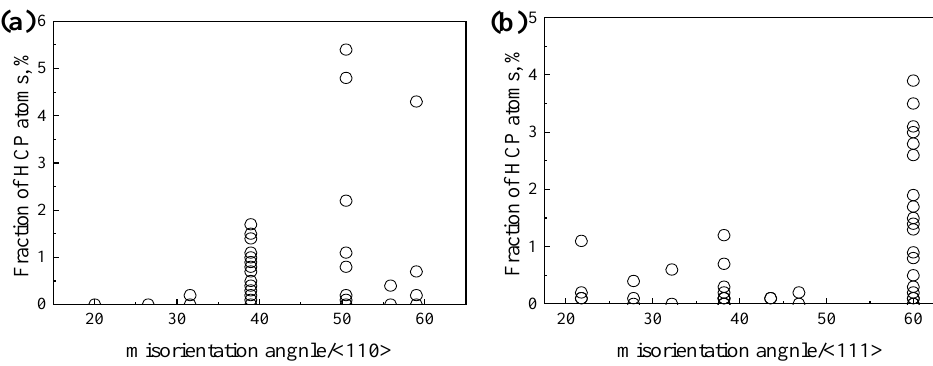
Figure 8. The fraction of HCP atoms as a function of the misorientation angle for GBs with the misorientation axes of ( a ) <110> and ( b ) <111>, respectively.